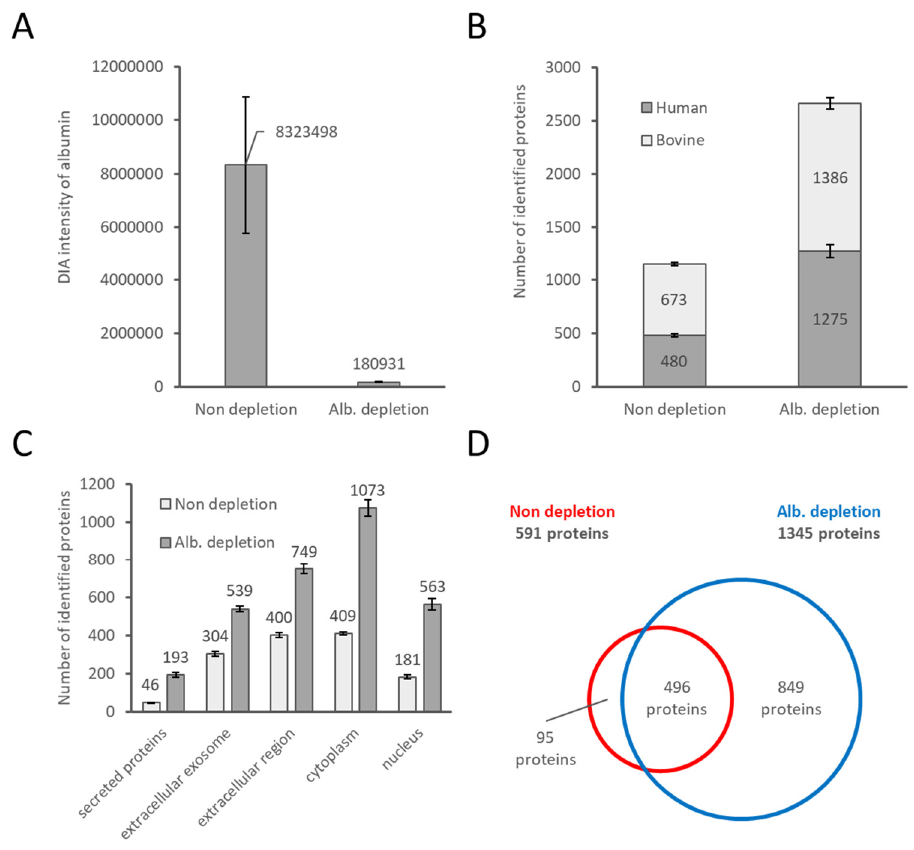
Figure 1. Effect of albumin depletion in the FBS-containing culture supernatant for proteome analysis. The undepleted and albumin-depleted samples were analyzed, with n = 3 each. ( A ) Amount of albumin by non-depletion and albumin depletion when normalized by the equivalent volume of the supernatant was analyzed by LC-MS. ( B ) Bar graph of the number of human and bovine proteins observed by proteome analyses. ( C ) Comparison of cellular localization by gene ontology (GO) enrichment analysis for the identified human proteins. ( D ) Venn diagram of the number of human proteins observed by proteome analyses. For ( B , C ), the results of the MS data individually analyzed by the Scaffold DIA software were used. For ( D ), the results of the simultaneously analyzed MS data collected for each treatment by the Scaffold DIA were used. Abbreviations: ALB, serum albumin.